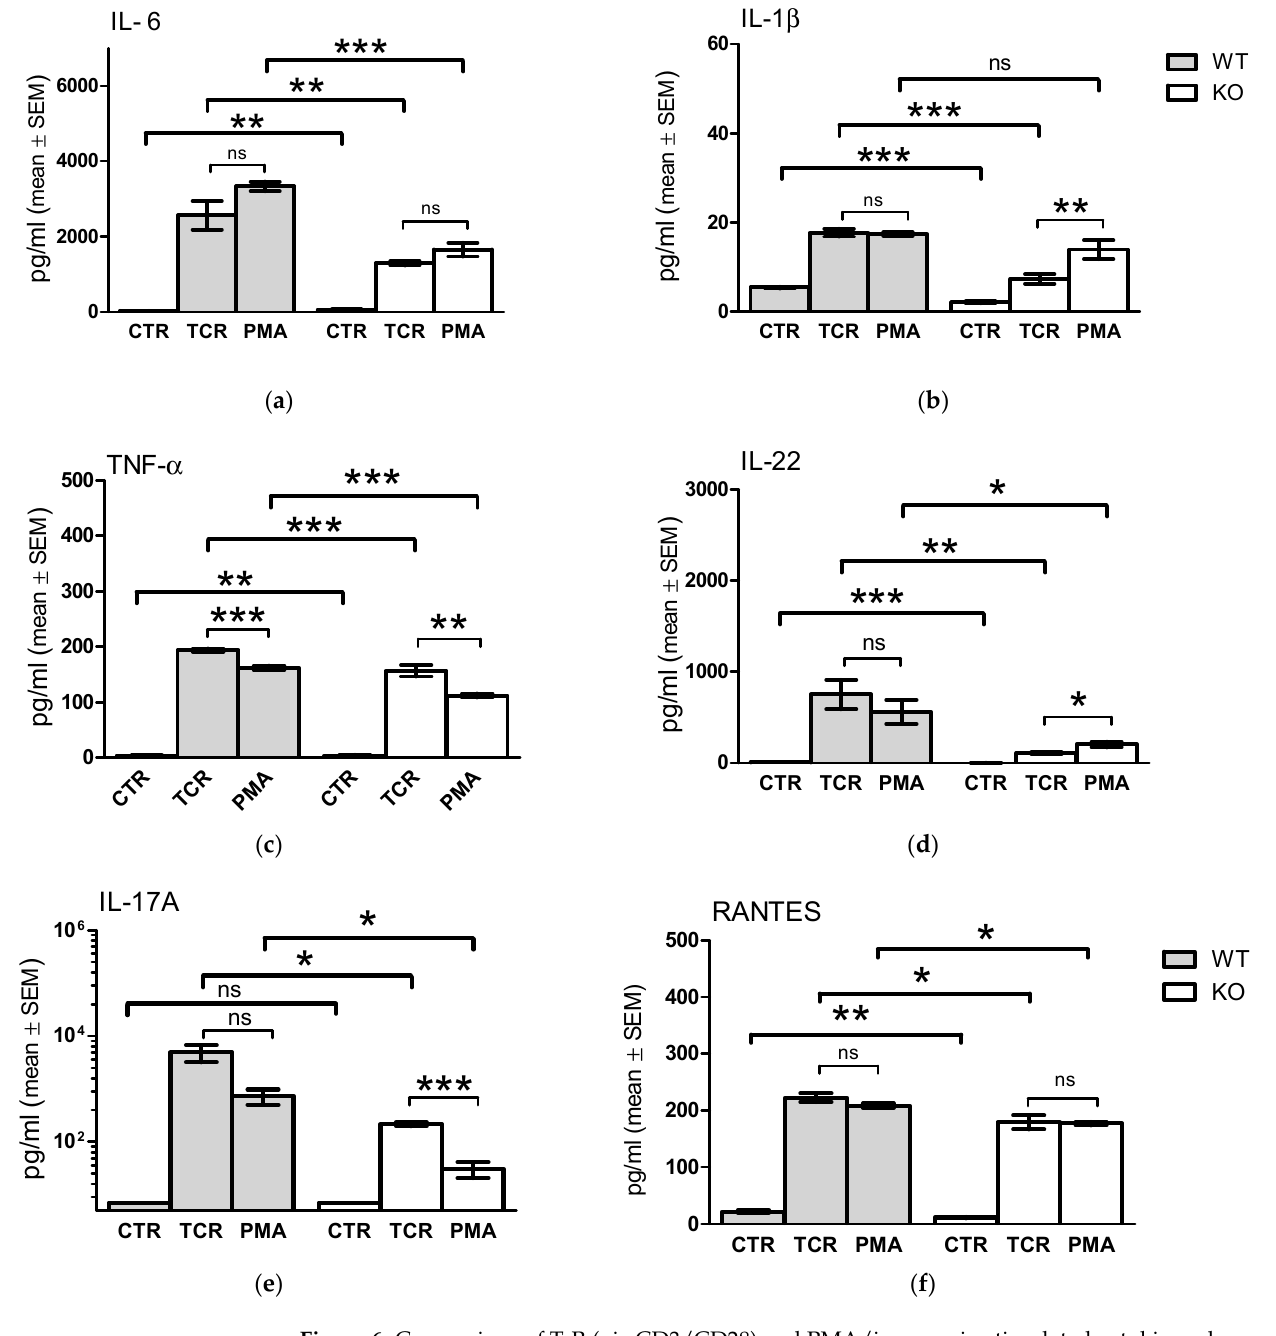
Figure 6. Comparison of TcR (via CD3/CD28) and PMA/ionomycin stimulated cytokine release of splenocytes from WT and KO animals. ( a ) Interleukin-6 (IL-6); ( b ) interleukin 1-beta (IL-1 β ); ( c ) tumor necrosis factor-alpha (TNF- α ); ( d ) interleukin-22 (IL-22); ( e ) interleukin-17A (IL-17A); ( f ) Regulated on Activation, Normal T-cell Expressed and Secreted (RANTES) in lymphocyte cell cultures isolated from TRPA1 WT or KO animals following TcR or PMA treatments. Columns represent mean ± SEM. ( a – d ) n = 5, ( e , f ) n = 3, * p < 0.05, ** p < 0.01, *** p < 0.001, ns indicates non significant. 2.6. In Vitro TcR (anti-CD3) Stimulated Calcium Signal and Basal Intracellular Ca 2+ Level in Lymphocytes and Thymocyte Subpopulations of WT and KO Mice